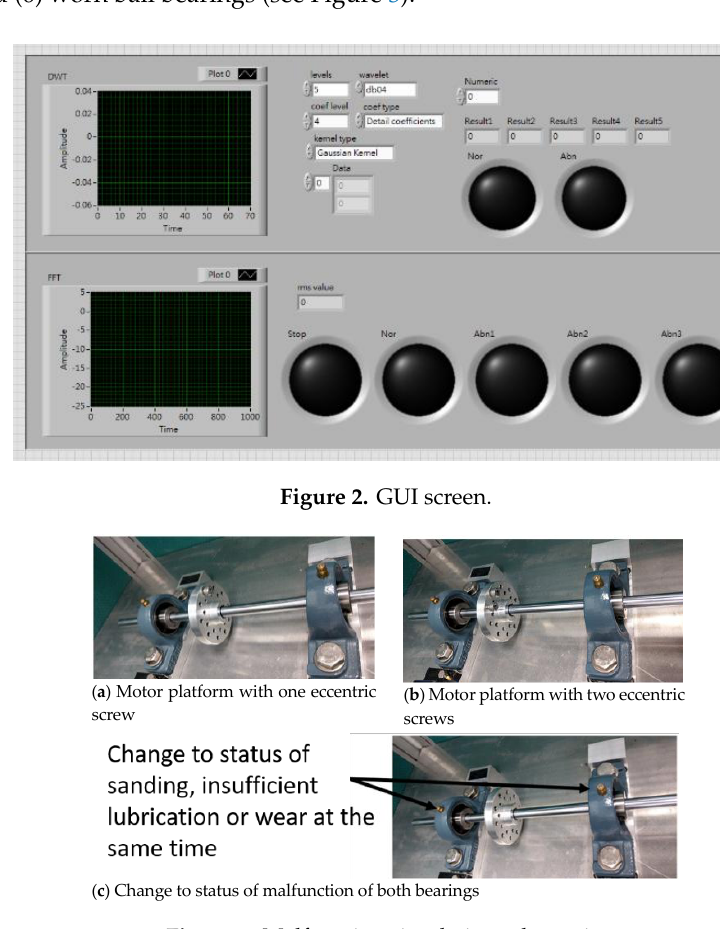
Figure 3. Malfunction simulation schematic.